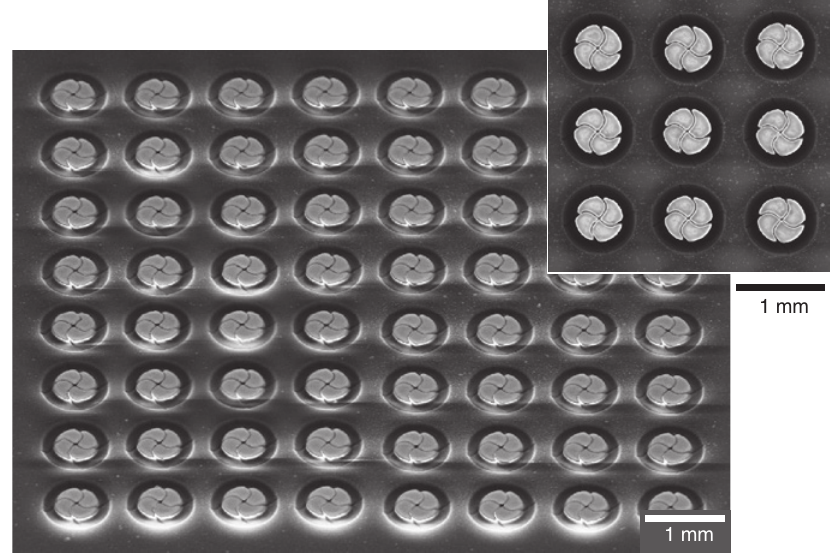
Figure 8: SEM images of chiral Au nanoparticles made by combined EBL with lift-off and FIB milling [90]. Charging of surface during SEM imaging, which causes bright artifacts and horizontal streaks.